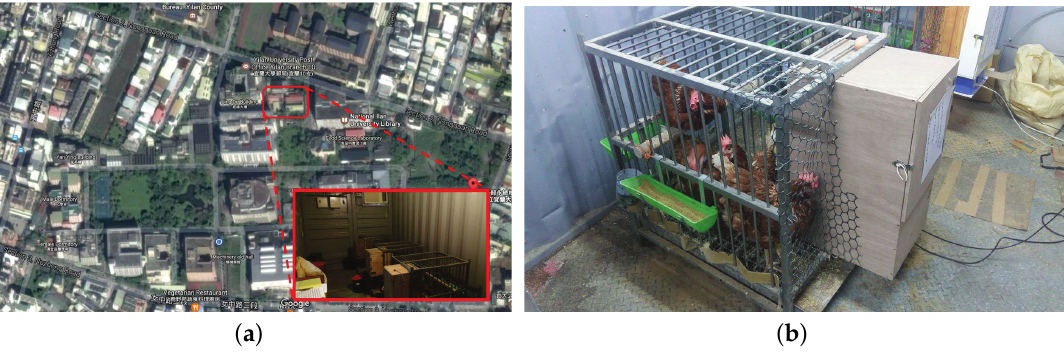
Figure 5. Experimental housing system. ( a ) Location of the experimental field; ( b ) an photo of the experimental housing